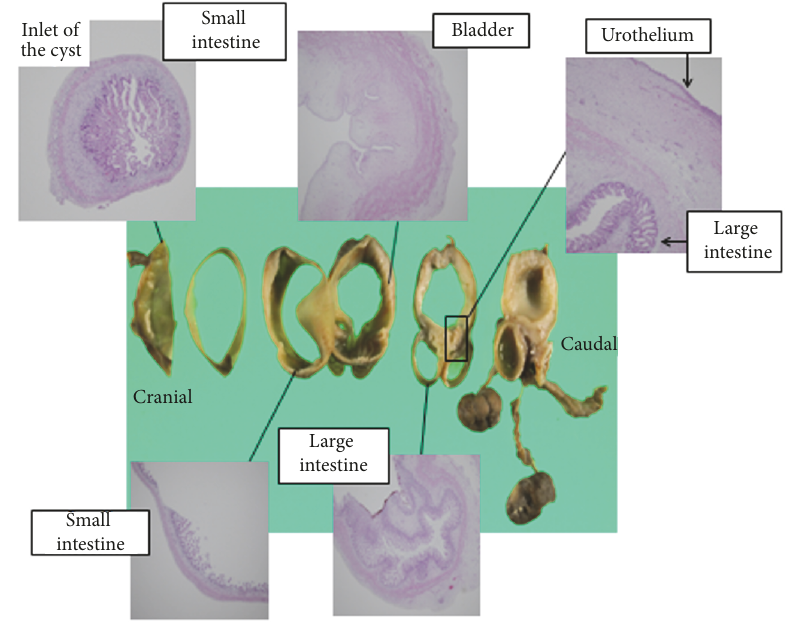
Figure 3: Sections of the specimen of the fetal abdominal cyst and histologic findings (hematoxylin and eosin staining, × 40).